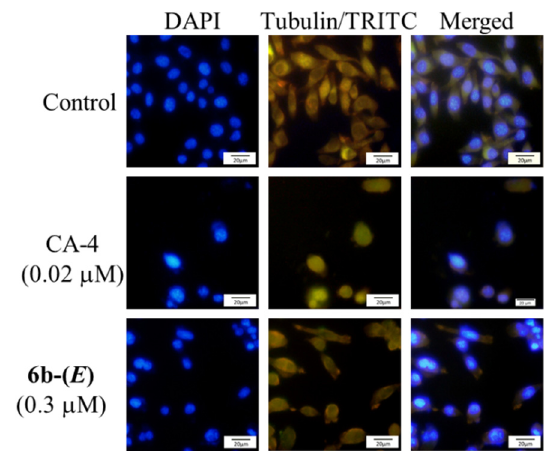
Figure 5. Immunofluorescence effects of 6b-( E ) (0.3 μM) and CA-4 (0.02 μM) on inhibition of tubulin polymerization in HepG-2 cells. After treatment for 48 h, the cells were stained with DAPI (blue, left panel) for nucleus and an anti-α-tubulin antibody (TRITC, green, middle panel) for microtubules. The right panel represents a merge of the corresponding left and middle panels. Images were acquired with an Olympus fluorescence microscope using a 20× objective.